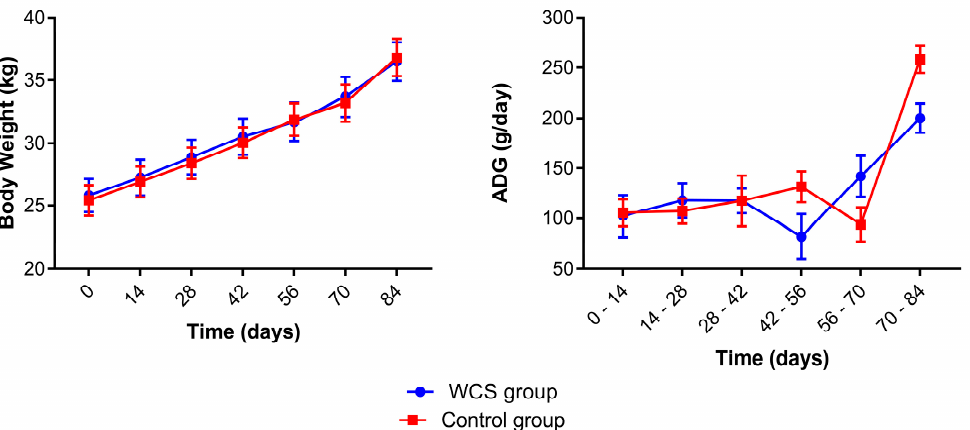
Figure 2. Mean ( ± standard error of the mean) of body weight (kg) values and average daily weight gain (ADG) of crossbred lambs naturally infected with gastrointestinal nematodes and Eimeria spp. receiving two different diets (whole cottonseed and control) at seven different samplings (0–84 days). There was an interval of 14 days between each sample collection.